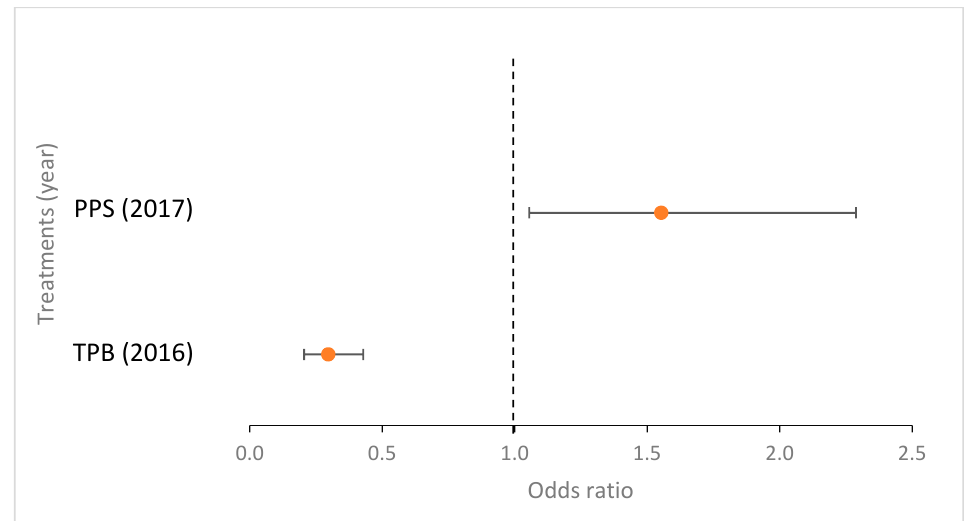
Figure 5. Effects of the two treatments with significant effects on the likelihood of Rhizoctonia sp. tuber infection (compared to control) assessed in three consecutive study years. Treatments: PPS contains Pseudomonas protegens , Pseudomonas jessenii , Stenotrophomonas maltophilia ; TPB contains Trichoderma atroviride , Pseudomonas putida , Bacillus subtilis . The horizontal (X) axis shows the treatments with significant results, the vertical (Y) axis shows the odds ratios, n = 400 in each group.